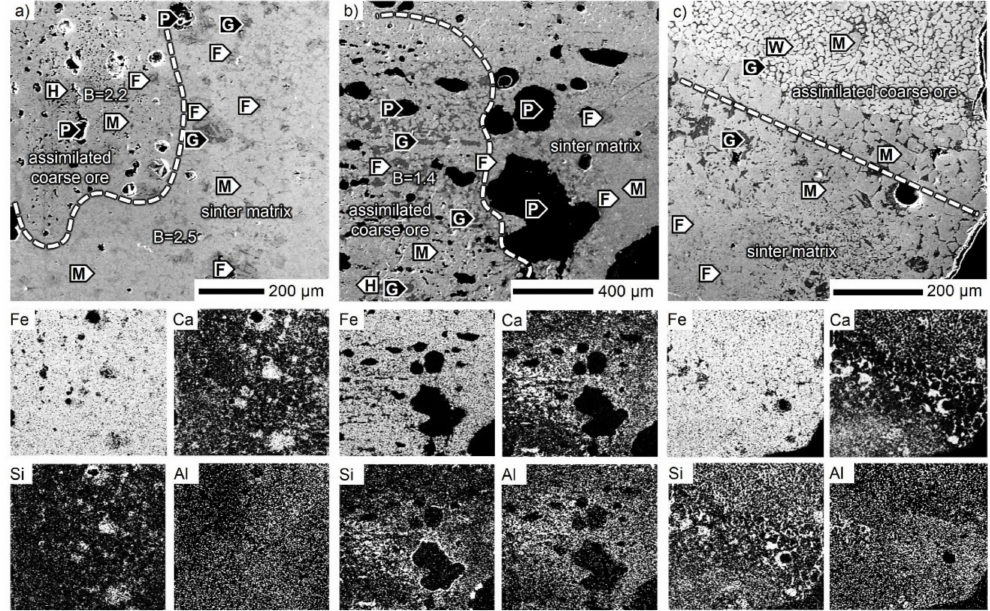
Figure 9. SEM micrographs of the SM-A sinter. B: CaO/SiO 2 , F: SFCA, G: glass, H: hematite, M: magnetite, P: pore, W: